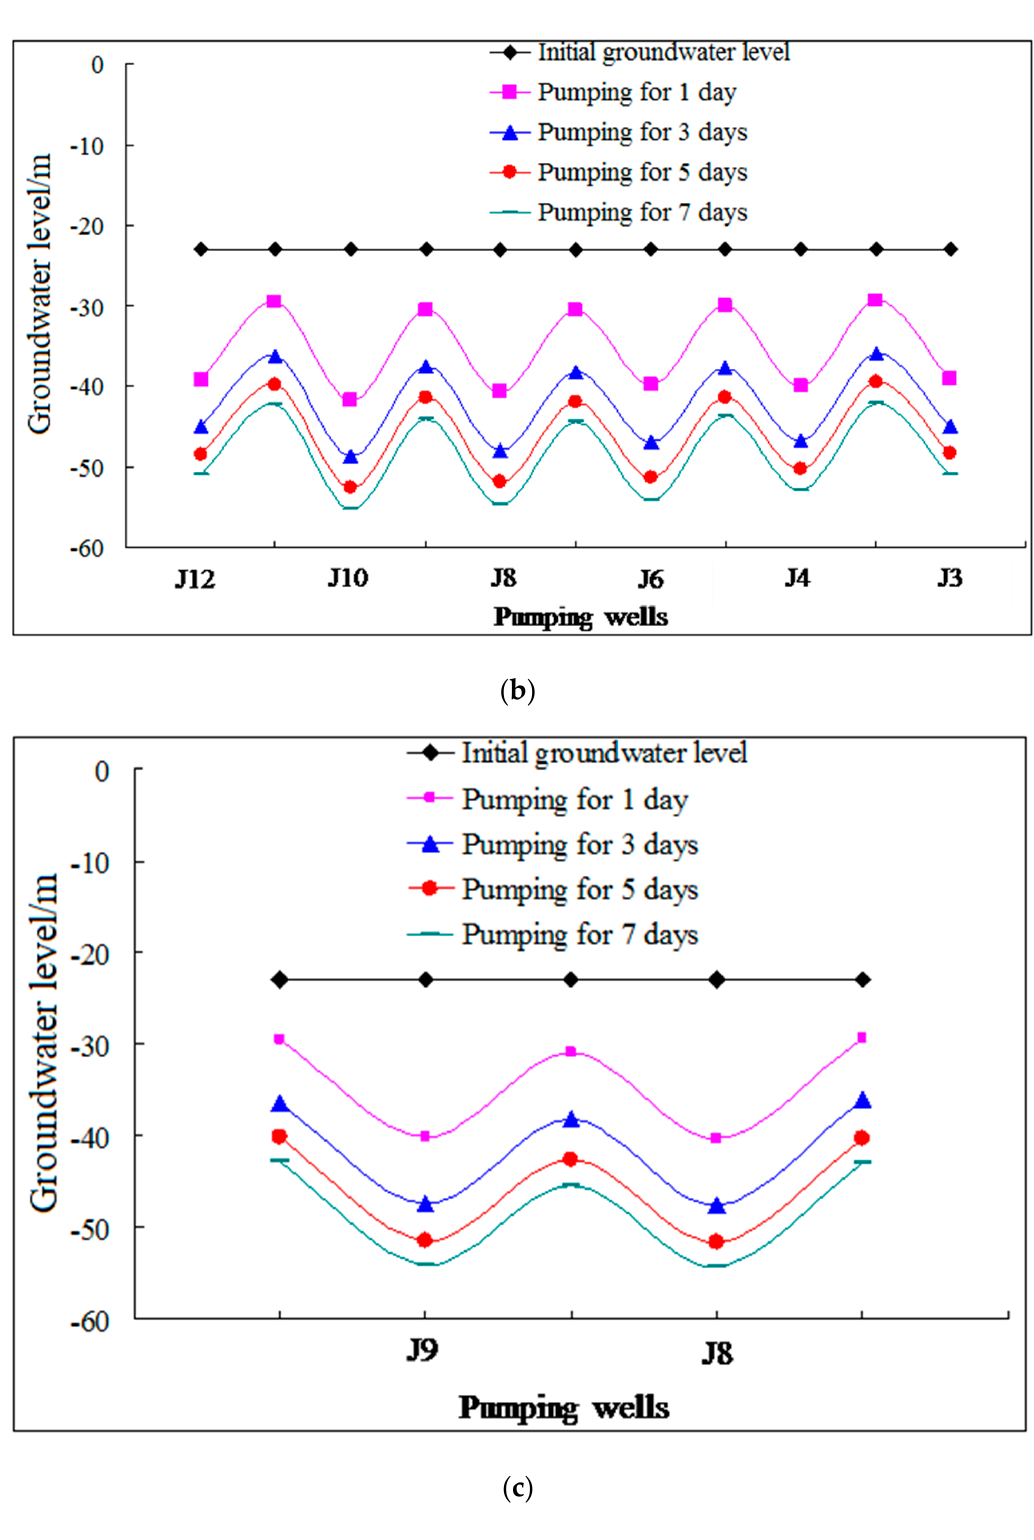
Figure 11. Curves of the cone of depression during pumping (( a ) Section J13-J1, ( b ) Section J12-J3, ( c ) Section